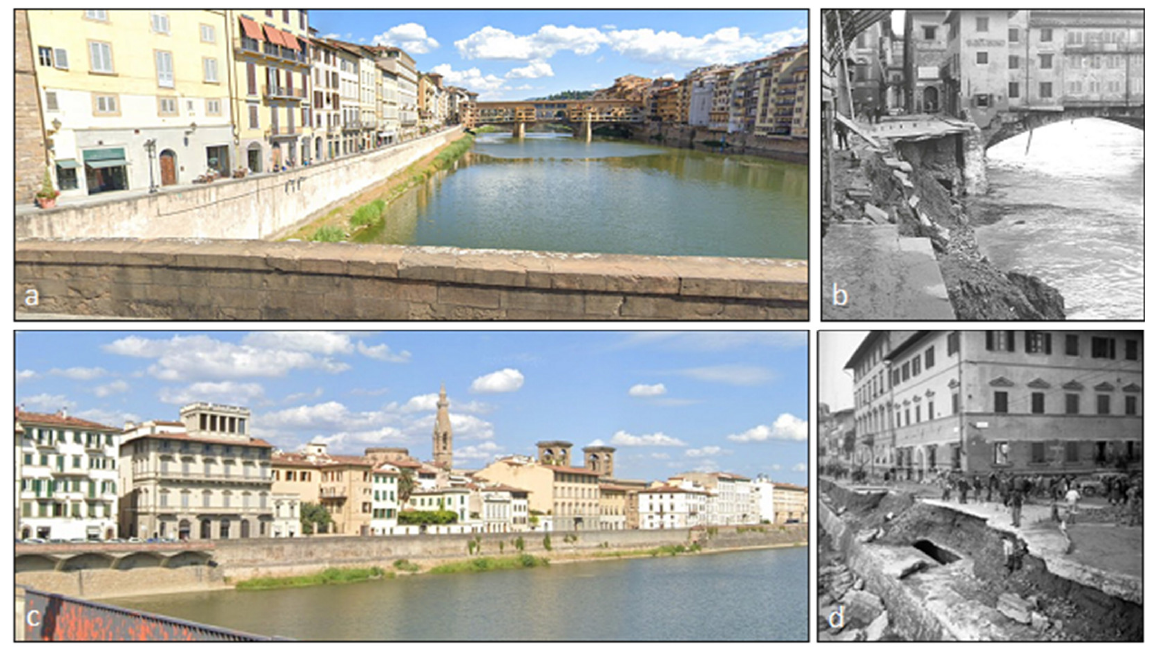
Figure 1. Lungarno degli Acciaiuoli riverbank: currently ( a ) and after flood of 1966 (Alinari archive), the embankment viewed from Ponte Vecchio of collapse of riverbank ( b ); Lungarno delle Grazie riverbank: currently ( c ) and after flood of 1966 (Alinari archive) ( d ).